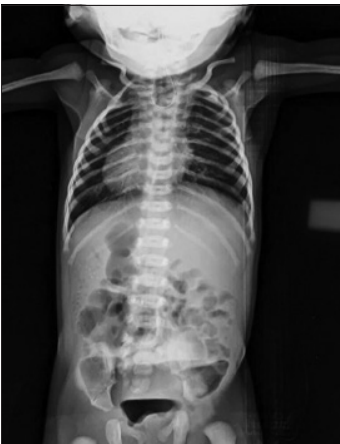
malformationFigure 1: X-ray photograph showing coiled nasogastric tube in the esophagus and air